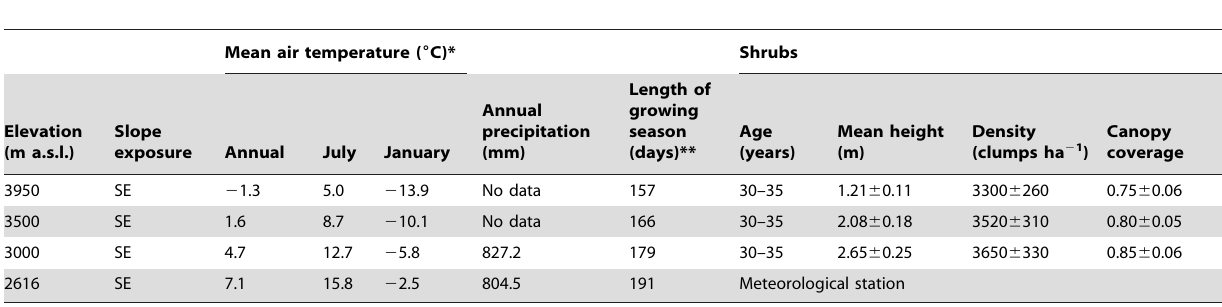
Table 1. Characteristics of the sites and the Quercus aquifolioides shrub stands studied on a SE-facing slope of Mt. Zeduo, Sichuan, SW